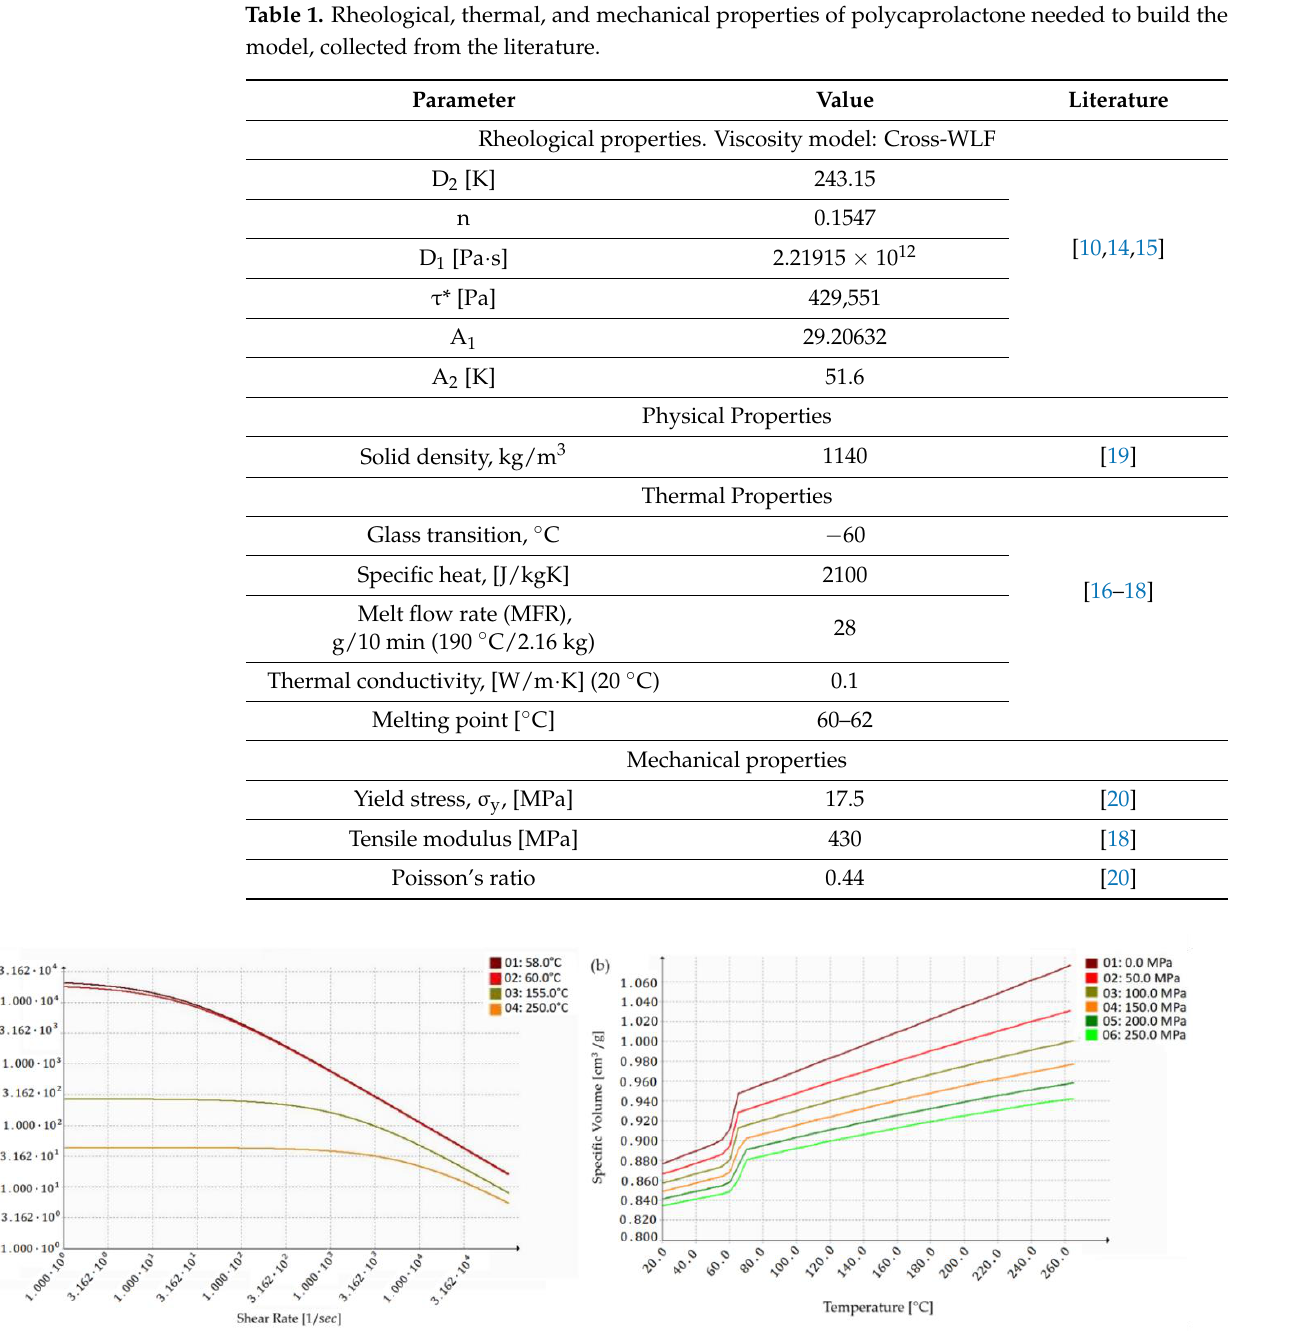
Figure 1. ( a ) Viscosity–shear rate plot (based on cross model data); ( b ) temperature-specific volume plot (based on Tait equation data).